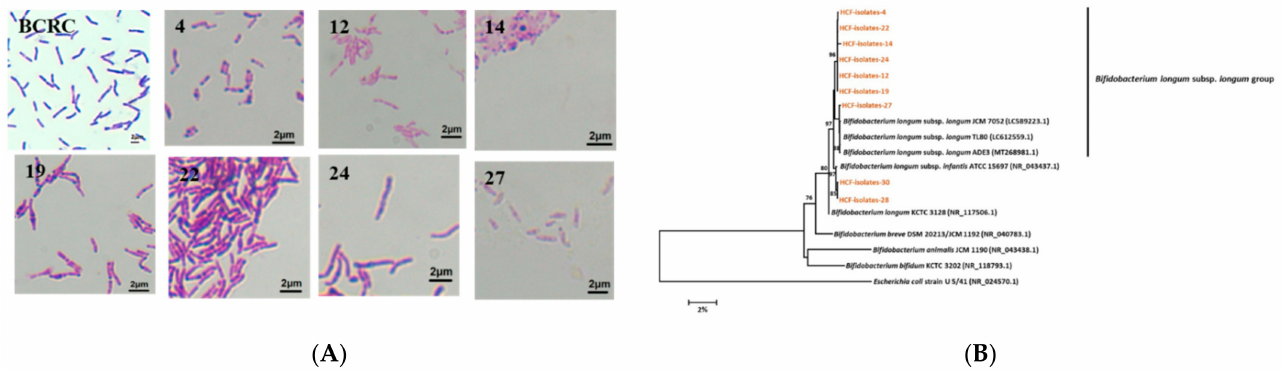
Figure 5. ( A ) Gram staining of Bifidobacterium longum subsp. longum from BCRC, HCF isolates-4, HCF isolates-12, HCF isolates-14, HCF isolates-19, HCF isolates-22, HCF isolates-24, and HCF isolates-27. ( B ) Phylogenetic tree based on the 16S rRNA sequence analysis constructed by the neighbor-joining method. Escherichia coli was used as the outgroup. The bootstrap values (expressed as percentage of 1000 replications) >70% are shown at branch points. Scale bar represents 2% sequence divergence. Table 1. Identification of the nine lactic acid bacterial isolates using 16S rRNA gene sequences.